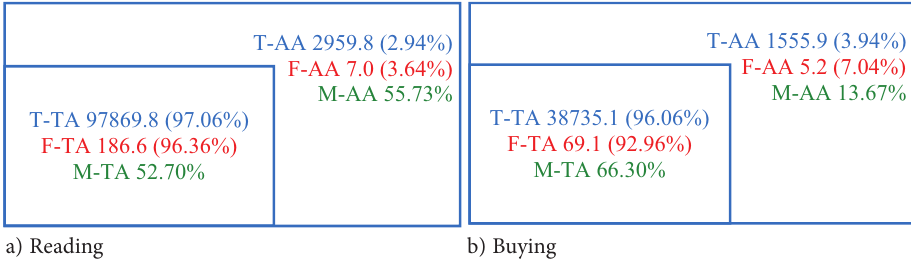
Figure 2. Visual representation of H1 and H2 by average fixation Time (T), average Fixation count (F) and short-term Memory (M) on Task Area (TA) and Advertising Area